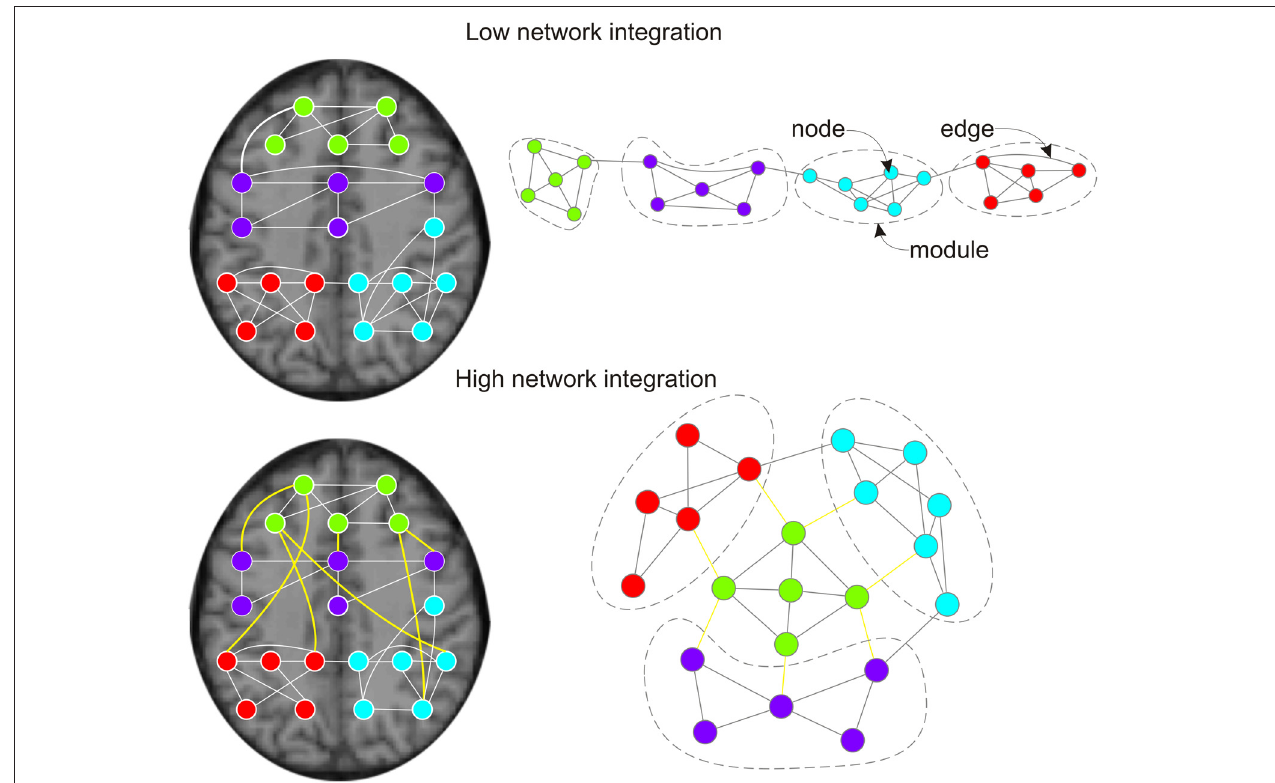
are related to increased integration of functional brain graphs, less serial processing and higher capacity for parallel information transfer. During pro-cognitive states nodes of different modules should be connected by shorter path lengths/fewer edges and brain modules are less clustered. Within the anatomical space brain modules are connected by an ensemble of functional connections with long physical distances (Alexander-Bloch et al., 2012; Vertes et al., 2012; lower left side: yellow edges). The global workspace theory of Dehaene and others (Dehaene et al., 1998; Dehaene and Naccache, 2001; Dehaene and Changeux, 2005, 2011) suggests that the pyramidal cells of the prefrontal cortex and their long cortico-cortical axons may be regarded as “workspace neurons” and play an important part in binding of different brain modules (Dehaene et al.,